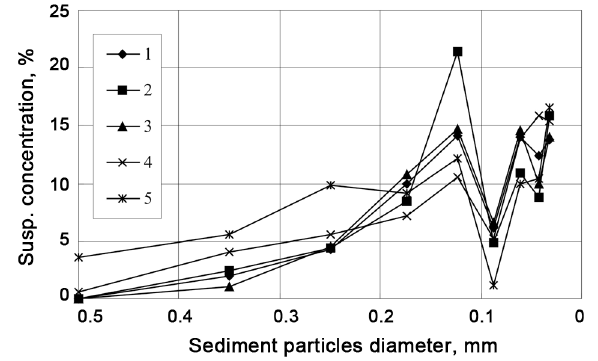
Fig. 8. Grain size distribution of suspended sediments estimated for the water example taken at the height 20 cm from the bottom for 5 variants of bottom